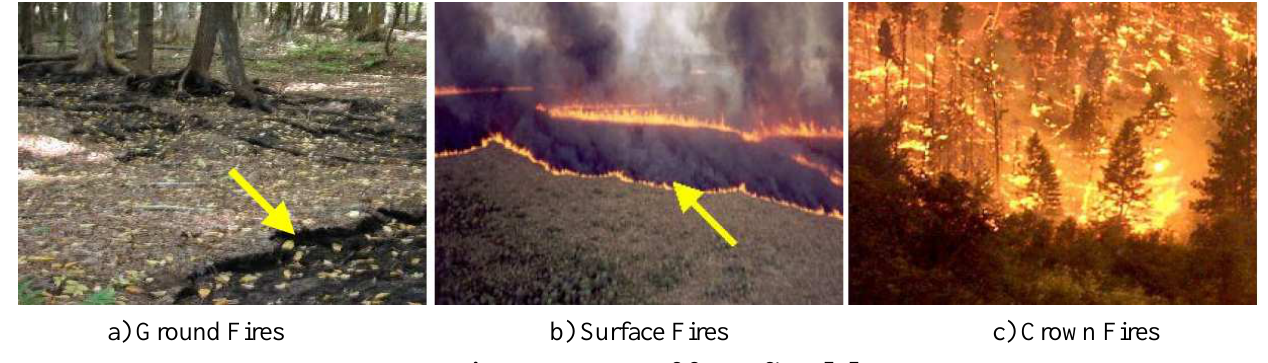
Figure 3. Types of forest fires